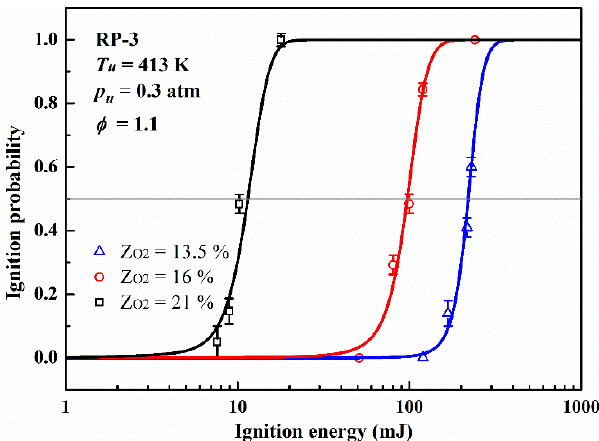
Figure 8. Effects of oxygen concentration on the ignition probability. ( T u = 413 K, p u = 0.3 atm, ϕ = 1.1, Z H2O = 0%)